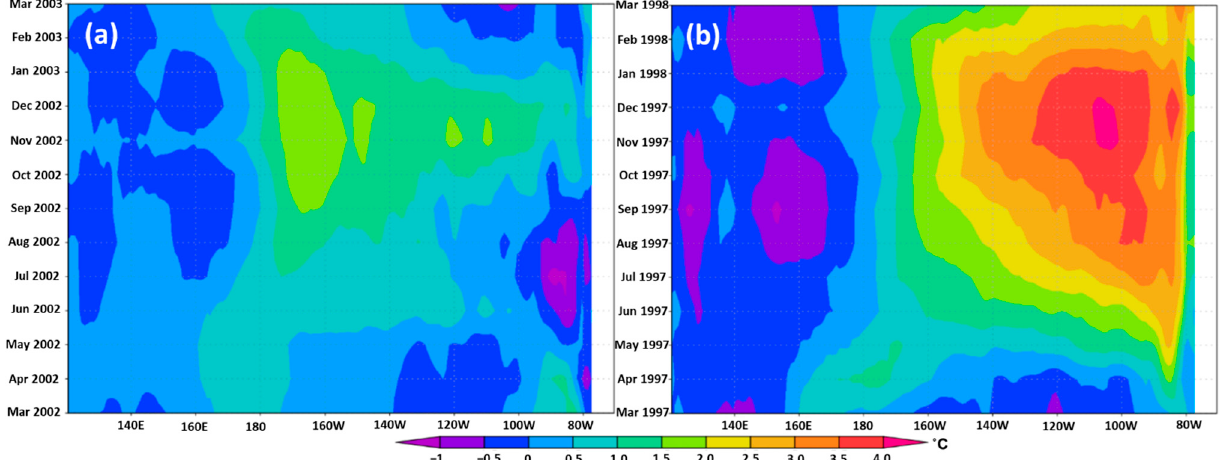
Figure 2. The temporal evolution of SSTA over equatorial Pacific during the CP episode in 2002/2003 ( a ) and the EP episode in 1998/1998 ( b ), units in °C.